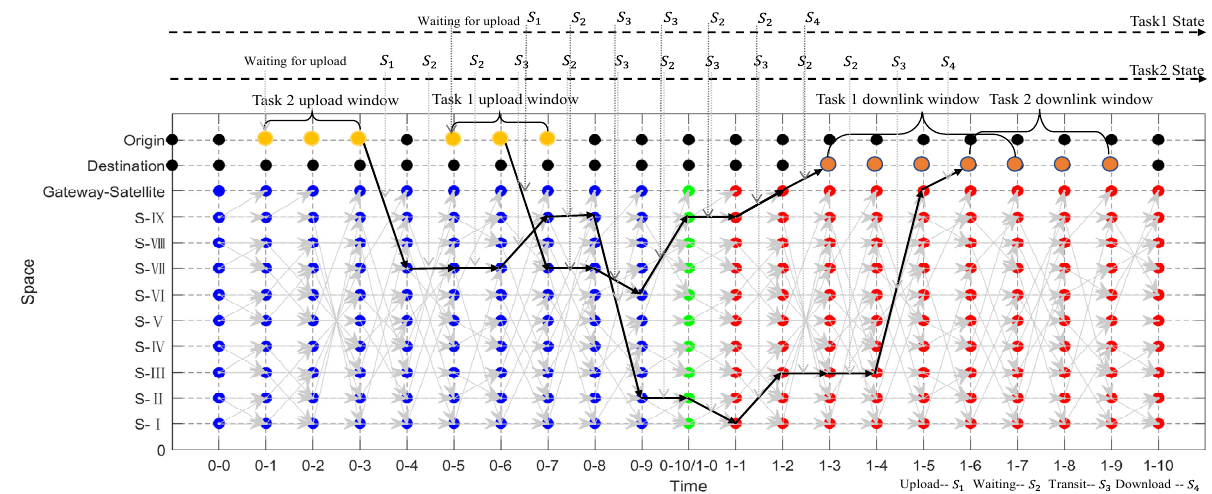
Figure 3. Time-space state network. Table 2. Task state transition representation.